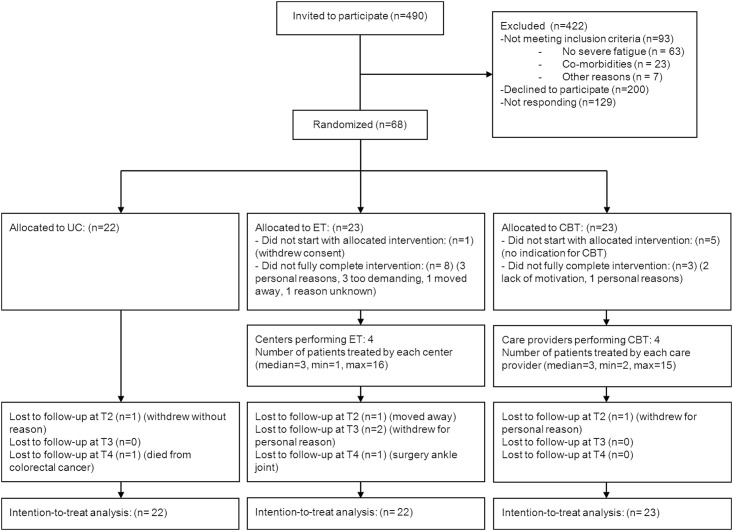
Flow diagram.Abbreviations: ET = exercise therapy; CBT = cognitive behavioral therapy.